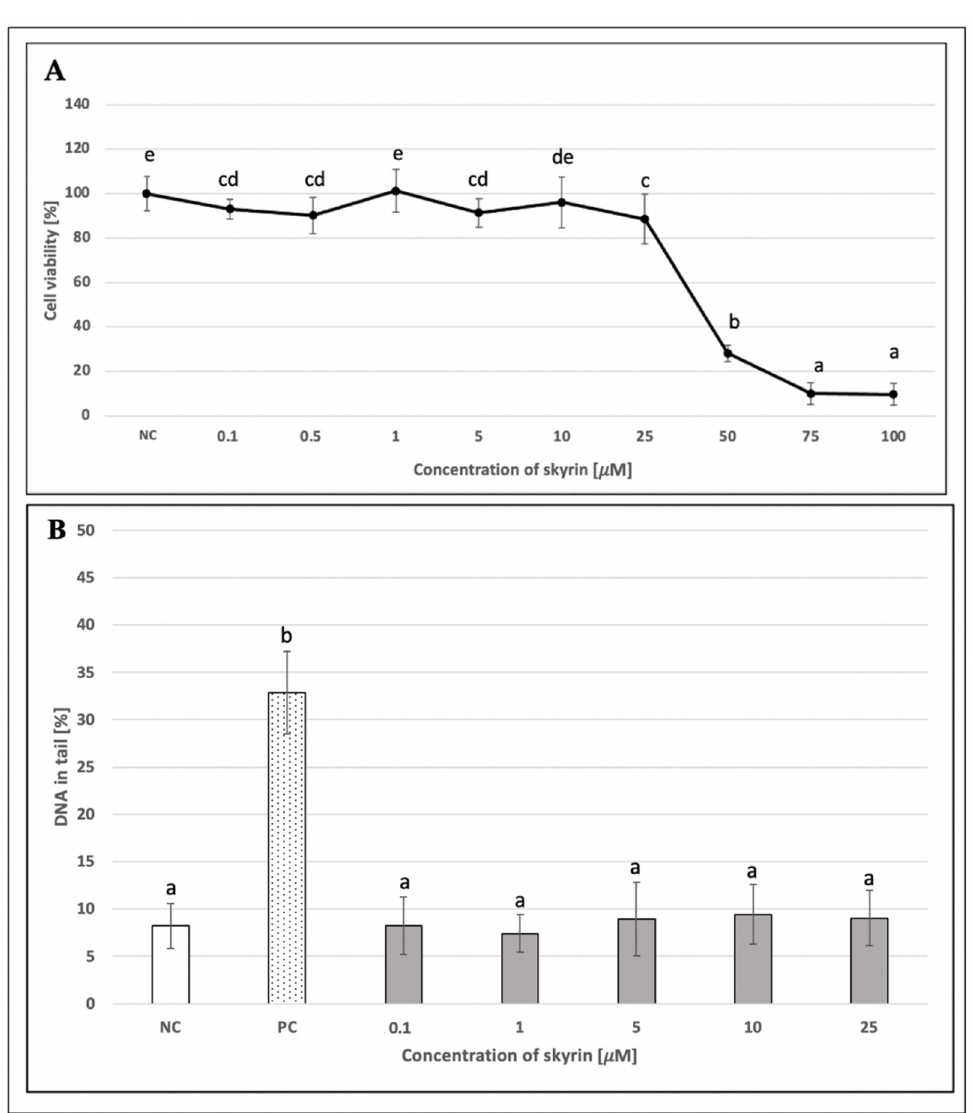
Figure 7. Evaluation of the potential cytotoxic ( A ) and genotoxic ( B ) effects of skyrin (SK) on the HepG2 cell line (24 h treatment) at different concentrations, using the MTT and comet assays. Negative control (NC)—untreated cells; positive control for comet assay (PC)—cells treated with 1 mM hydrogen peroxide. Results were analyzed by ANOVA single-step multiple comparisons of means using LSD tests, and comparisons between the mean values were considered significant at p < 0.05. Similar letters represent samples with no statistically significant differences between them. All experimental data in this work are from at least three independent experiments.